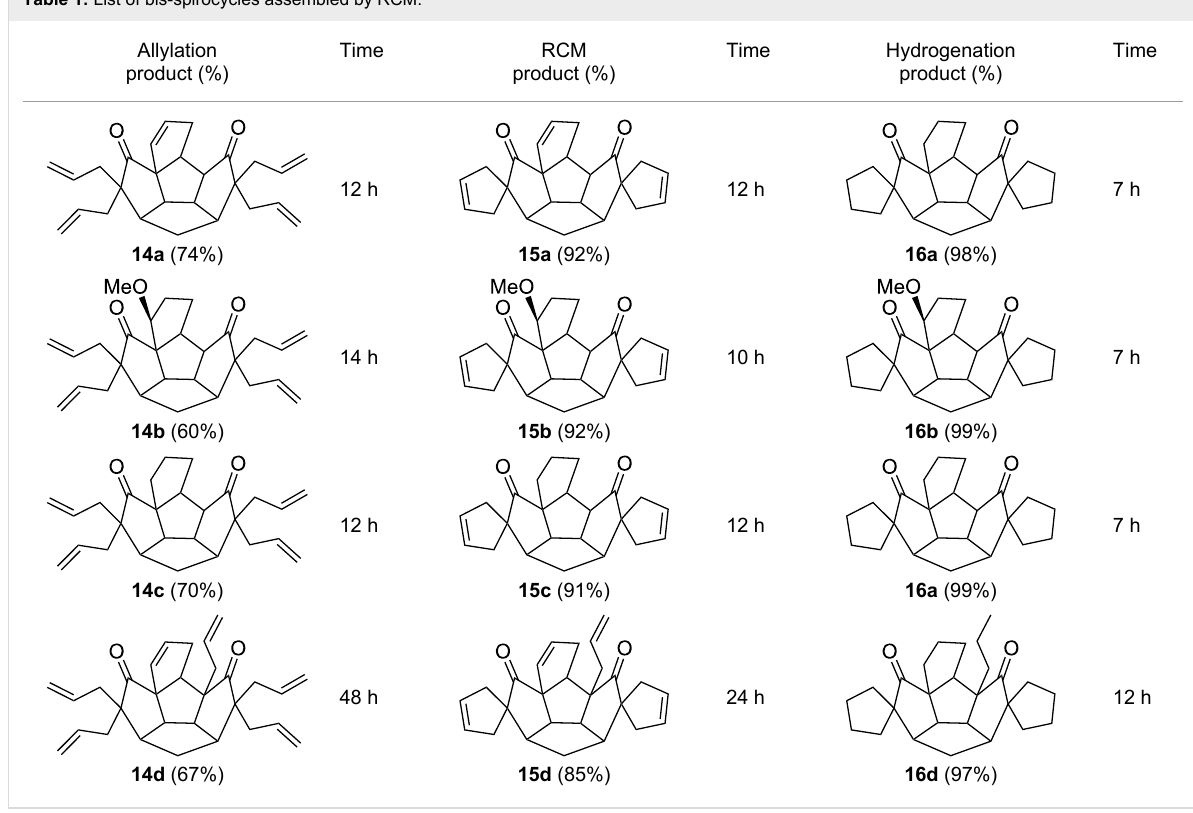
Table 1: List of bis-spirocycles assembled by